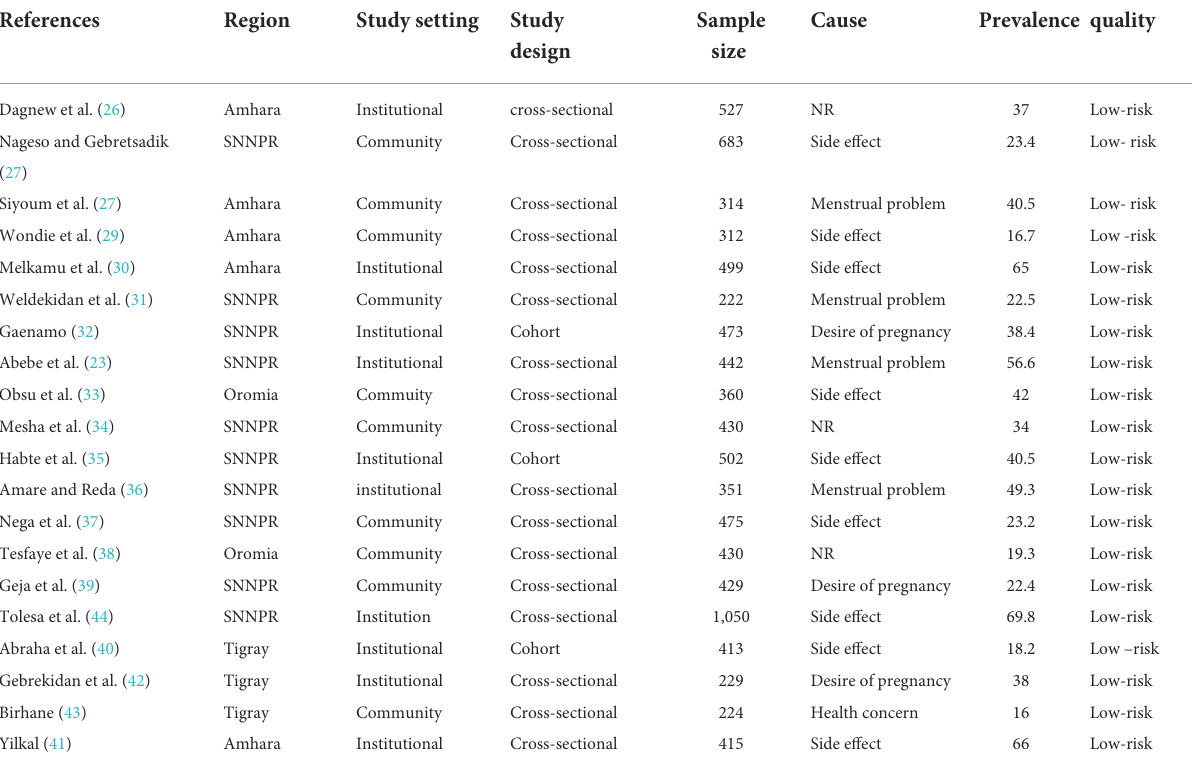
TABLE 1 Characteristics of the included studies in the systematic review and meta-analysis for the prevalence of discontinuation long acting reversible contraception in Ethiopia